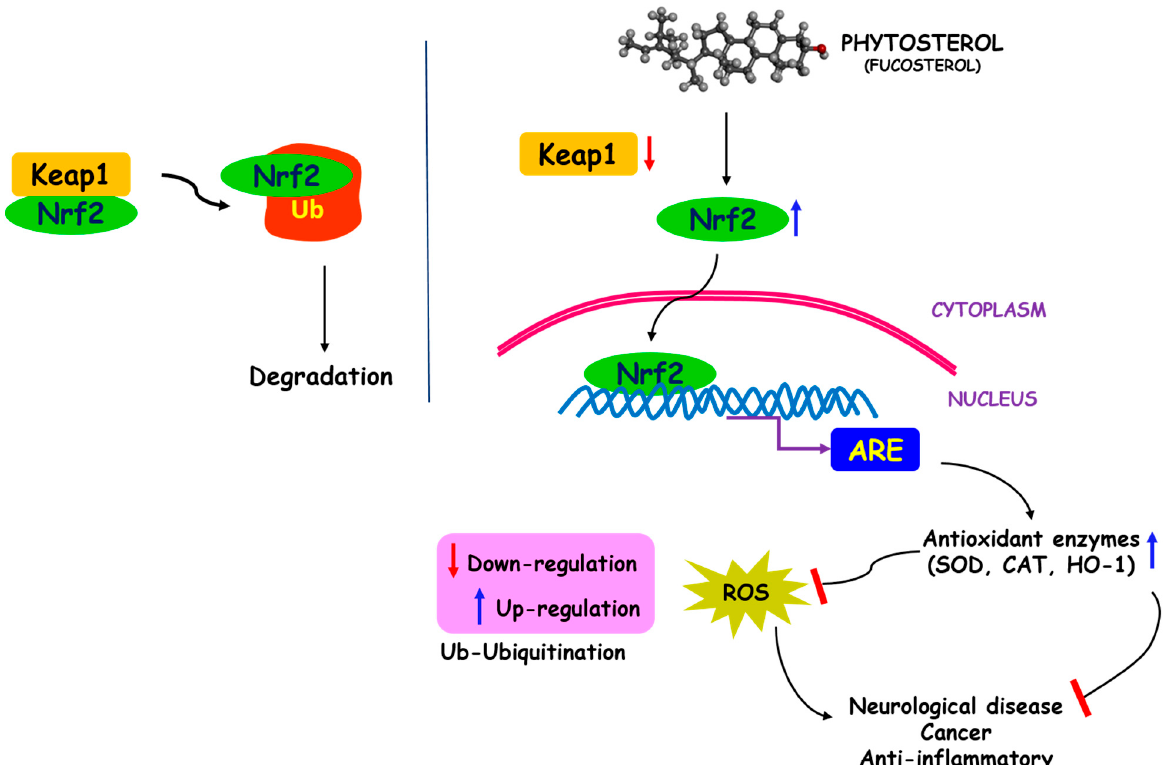
Figure 4. Schematic diagram representing the antioxidant mechanism of fucosterol. Up-regulation of antioxidant enzymes such as HO-1 (heme oxygenase-1), SOD, and CAT, via the Nrf2/ARE signaling pathways. The left image indicates the normal physiological conditions in which Nrf2 bound to keap1 in the cytosol undergoes degradation by the ubiquitination process.